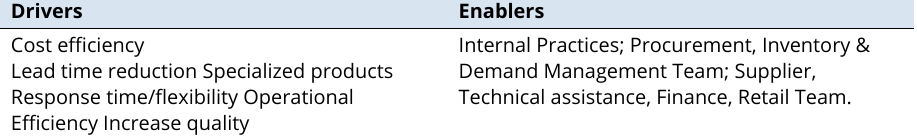
Drivers and enablers of strategic sourcing in the Pakistan Footwear